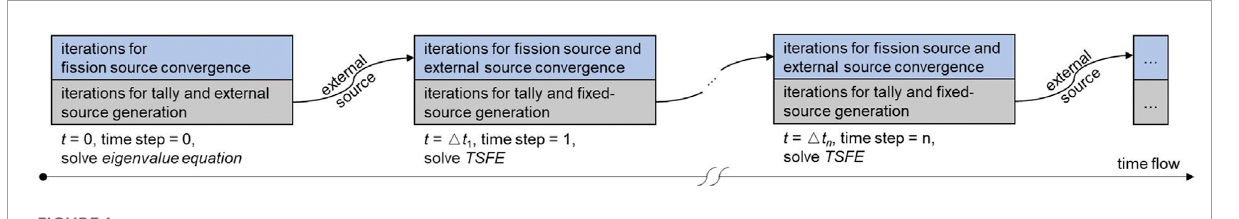
FIGURE 1 Flow chart of the PCQS MC